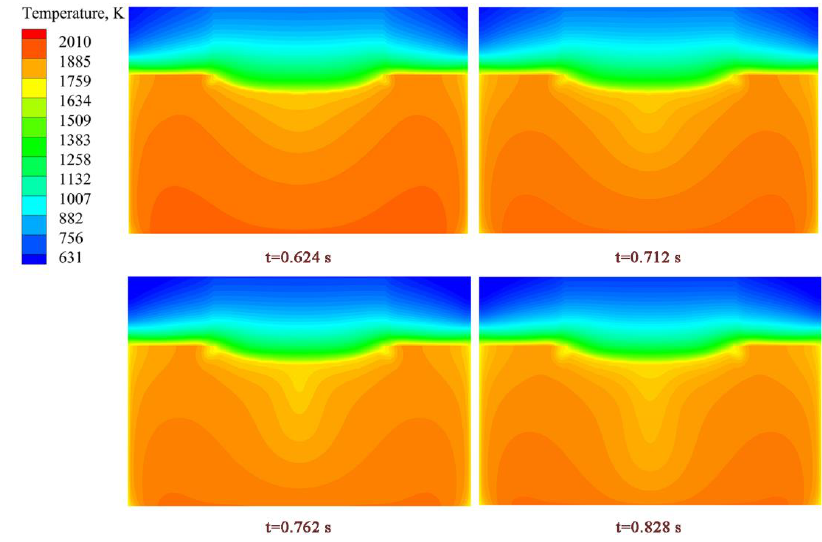
Figure 14. Distribution of the temperature field during the droplet dripping process of OE-ESR.